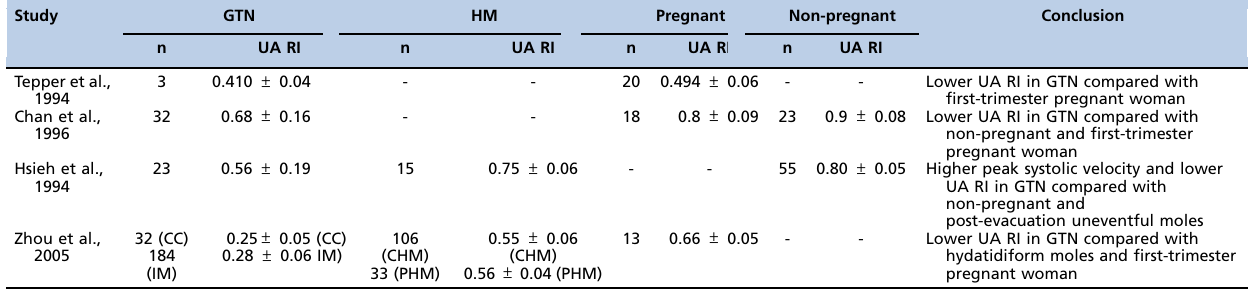
Table 2 - Studies that evaluated the UA RI in gestational trophoblastic disease, normal pregnancy and non-pregnant women. GTN: gestational trophoblastic neoplasia; HM: hydatidiform mole; n: number of patients; UA RI: uterine artery resistance index; CC: choriocarcinoma; IM: invasive mole; CHM: complete hydatidiform mole; PHM: partial hydatidiform mole.